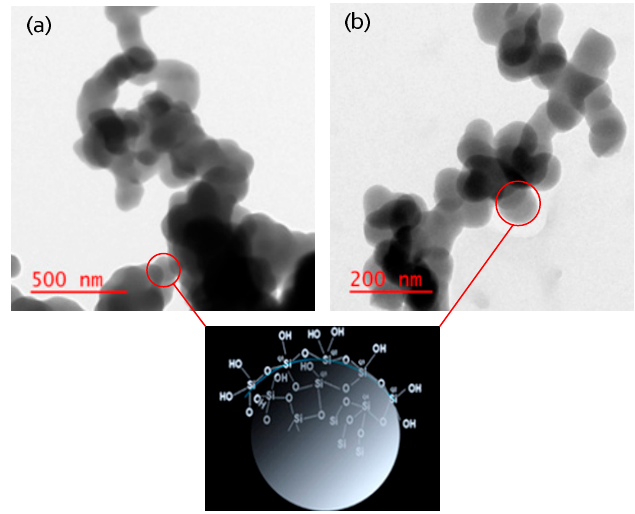
Figure 3. TEM images of silica particles ( a ) GPM/EtOH and ( b ) GPM/Acet.